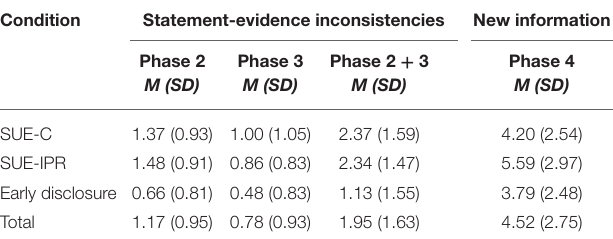
TABLE 1 | Descriptive statistics for the suspects’ verbal responses. Condition